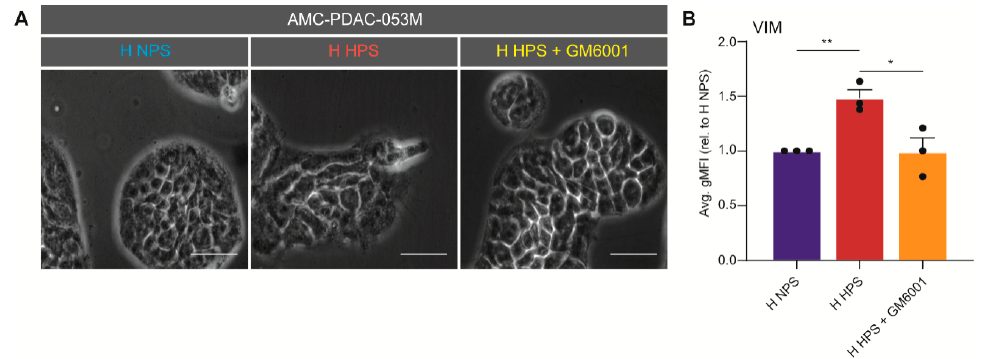
Figure 5. Tumor cell EMT is driven by MMP10. ( A ) AMC-PDAC-053M cells were treated with NPS, HPS, and HPS + GM6001 under hypoxia. Scale bar: 20 µ m. ( B ) Expression of VIM in cells were